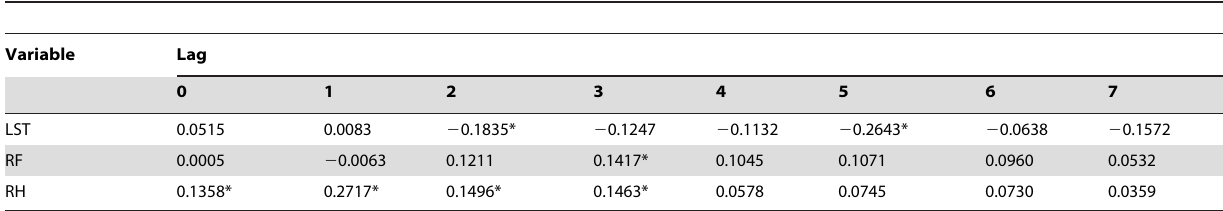
Table 2. Hong Kong: Cross-correlations between pre-whitened environmental series and the influenza counts.